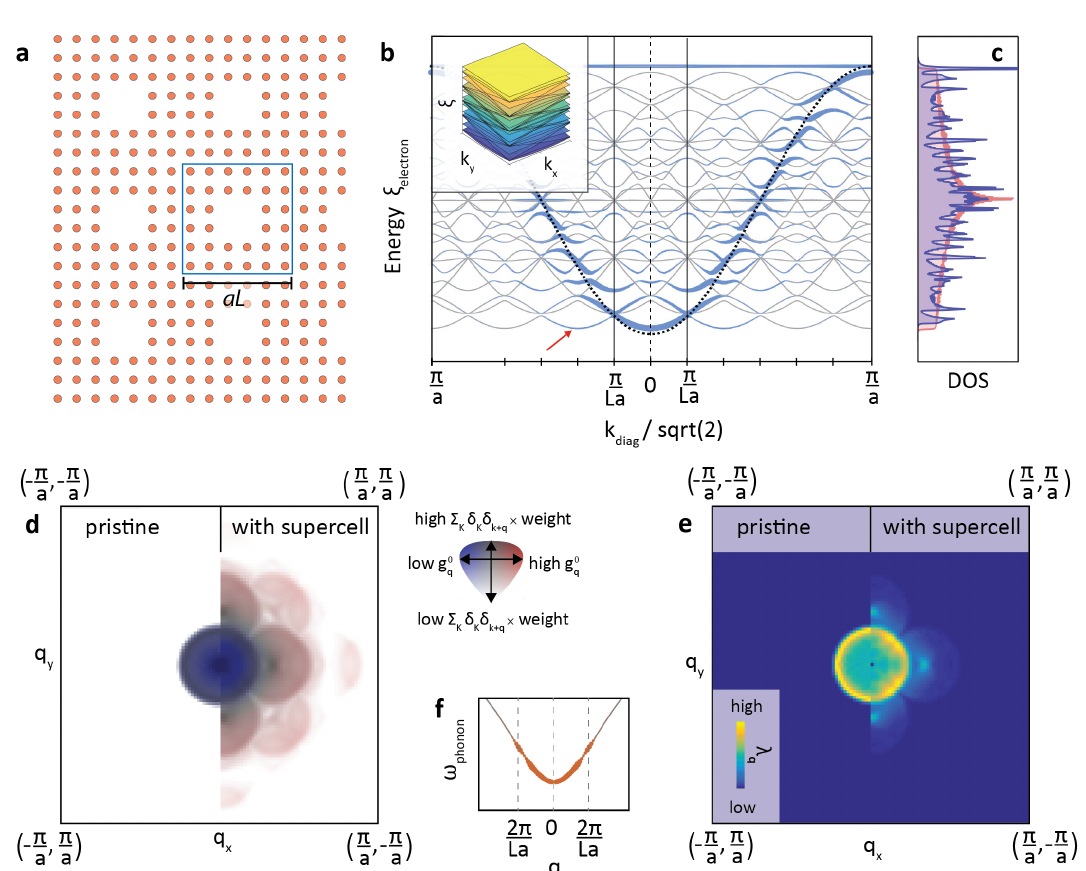
Figure 3: Increased electron-phonon coupling parameter λ . a , Illustration of our model with a square lattice and a 6 × 6 supercell with a 2 × 2 hole; results for different supercell sizes and shapes are in Fig. 4. b , The supercell periodicity reduces the size of the Brillouin zone by a factor L (black line). The extended Brillouin zone is plotted as we consider umklapp scattering between different zones. The bands ξ ν are shown in gray, the blue color marks the ‘weight’. k c , Density of states of the pristine material (red) and the material with supercell (blue). d , The phase space for scattering. The darkness indicates how much phase space is available, = g 0 the red-blue indicates the strength of the interaction matrix element g 0 . In the pristine q kq material, only small scattering vectors are allowed due to the kinematic constraints; in the modified material, larger q , where the interaction is stronger (red) are possible. e, f , λ as an q